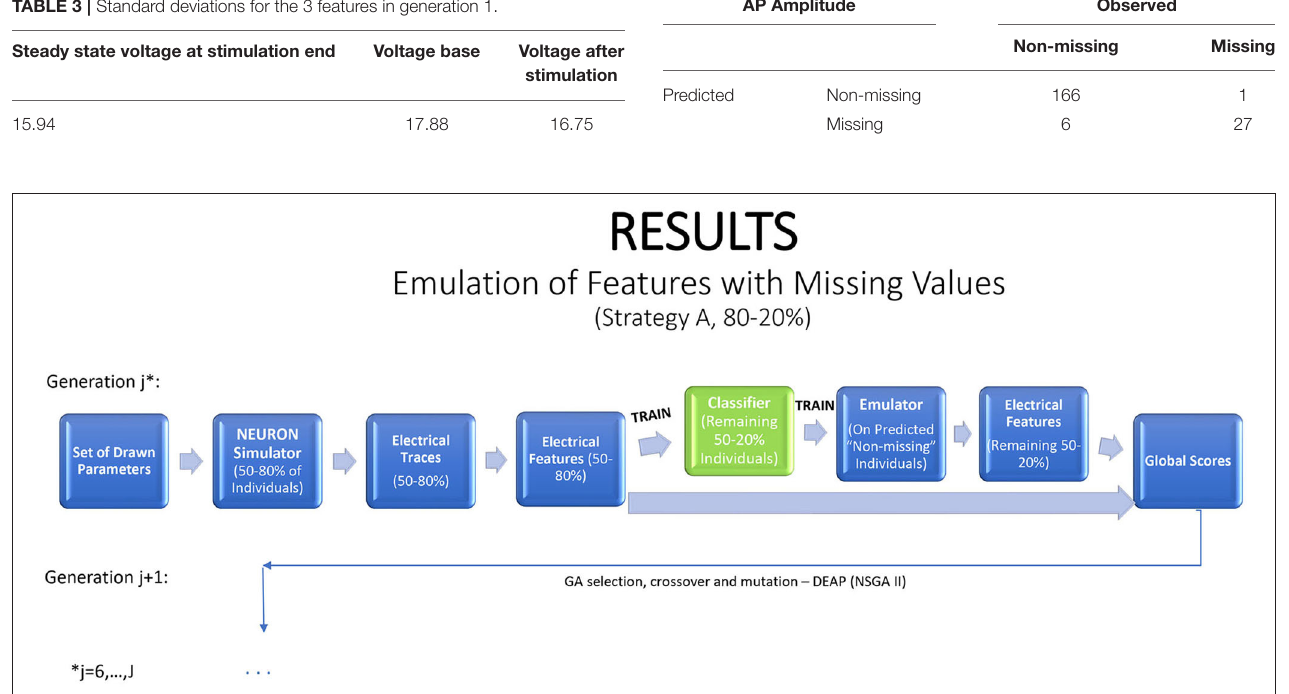
FIGURE 5 | A strategy for a modified genetic algorithm for features that are observed only in some of the traces. The strategy simulates traces for 80% of the individuals, using them to fit a classifier, which is applied to the remaining 20% of the individuals. If the classifier predicts that the feature will be observed, it is then predicted with an